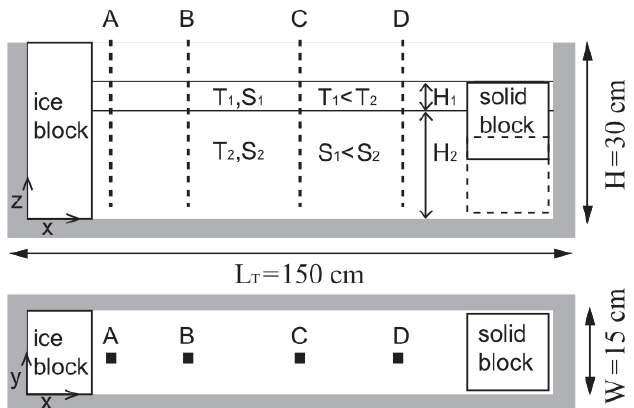
Figure 7. Top and side views of an experimental facility with a stratified flow and solid block that moves up and down to produce intermediary circulation along a vertically-oriented ice wall. The letters A to D and the dashed lines indicate the location of conductivity-temperature probes. Reproduced from [133], with permission from John Wiley and Sons,